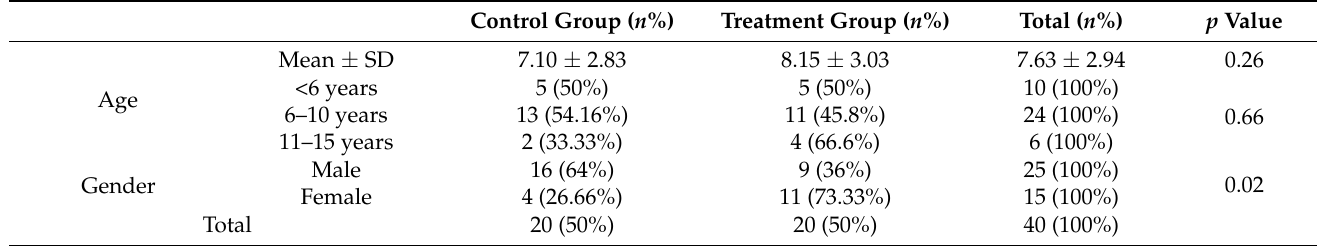
Table 1. Age and gender distribution of the study